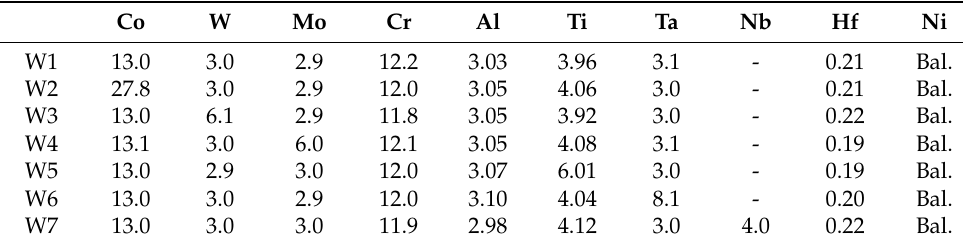
Figure 1. ( a ) The high throughput experimental preparation process of Ni-based superalloys; ( b ) The acquired microstructure by SEM at temperatures 900 ◦ C and 1000 ◦ C. Table 1. Measured composition of simple W1–W7 in